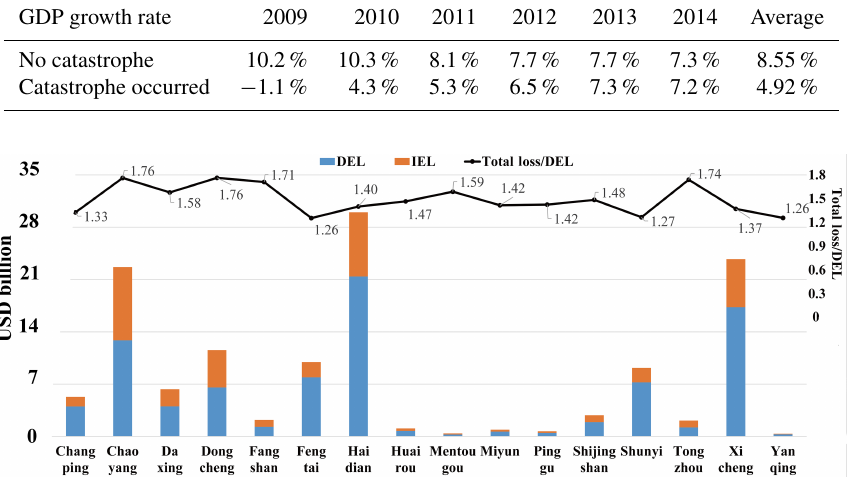
Figure 3. The direct and indirect economic loss of the districts of Beijing (BJ), and the ratios between total loss and direct economic loss. (Note: DEL is the direct economic loss, and IEL is the indirect economic